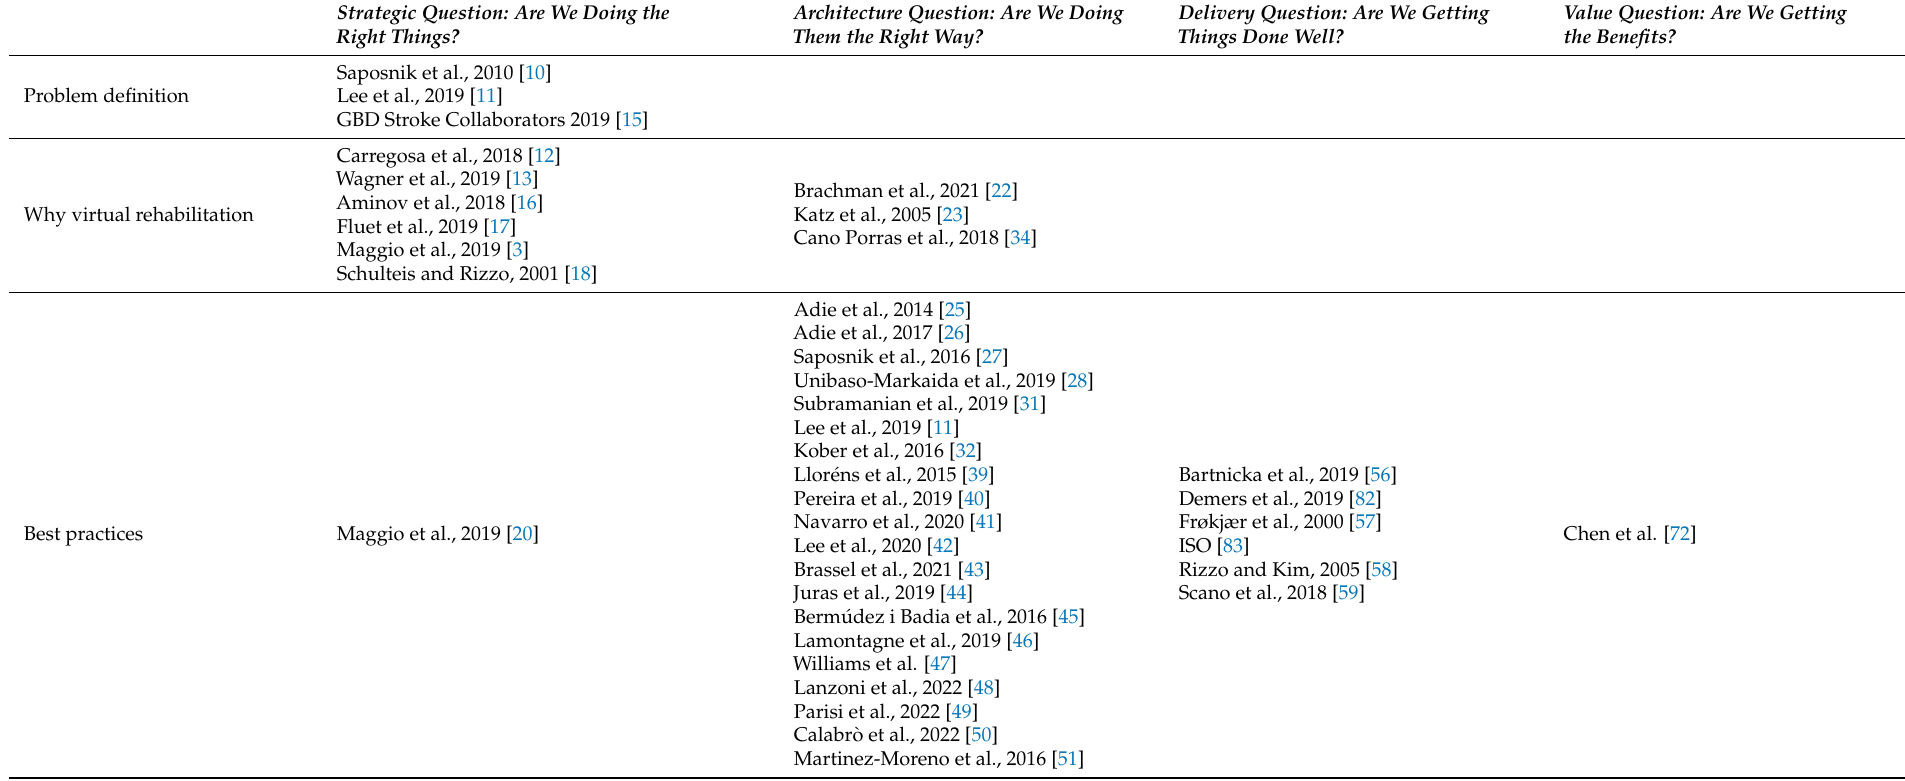
Table 1. Summary table of the different aspects evaluated in the different “are” questions together with bibliographic references that support